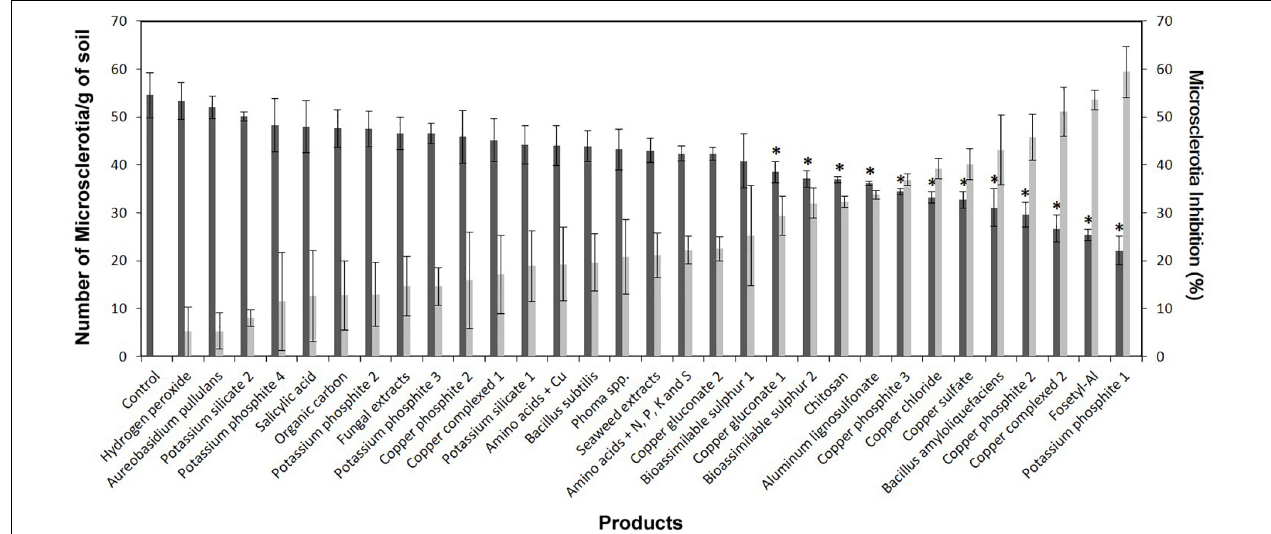
FIGURE 1 | Effect of the evaluated products on the microsclerotia (MS) concentration [Number of MS/g of soil (dark gray columns)] and on the viability of MS [MS inhibition (MSI), % (light gray columns)] of Verticillium dahliae in naturally infested soil. Treatments were performed using the irrigation dose indicated for each product in Table 1 . For each parameter, columns represent the average of six replicated plastic pots. Vertical bars represent the standard error of the means. For MS concentration, columns with an asterisk differ significantly from the control according to Dunnett’s multiple comparison test at P = 0.05. For MSI, significant differences between treatments were determined by a critical value for means comparison of 16.5% according to Fisher’s protected LSD test at P =